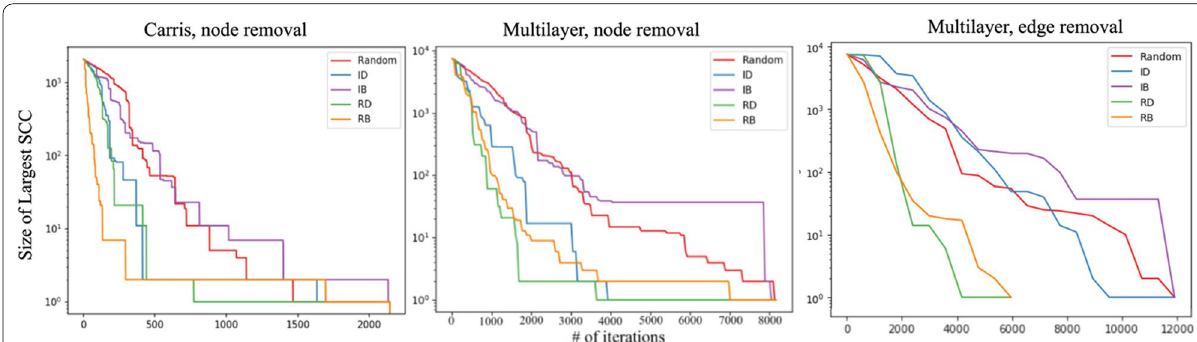
Fig. 9 Evolution of SCC size along node extraction strategies for a single layer, CARRIS (left), all layers (middle), and edge removal in multilayer network